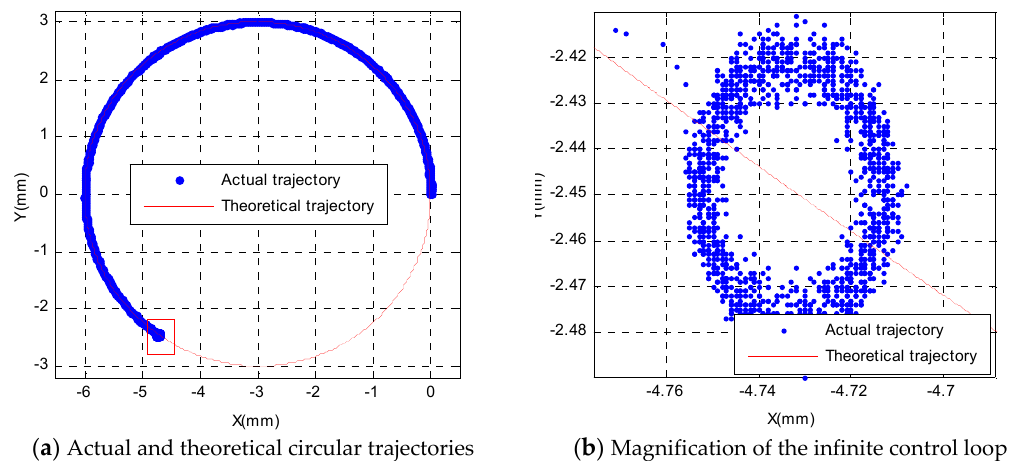
Figure 12. Circular trajectory tracking with a PI controller, K